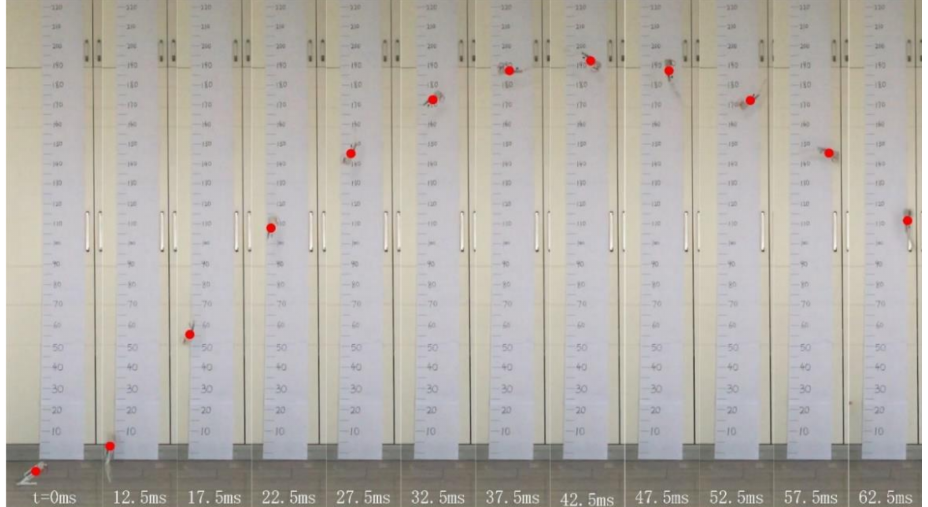
Figure 12. Arrayed frames during in-air